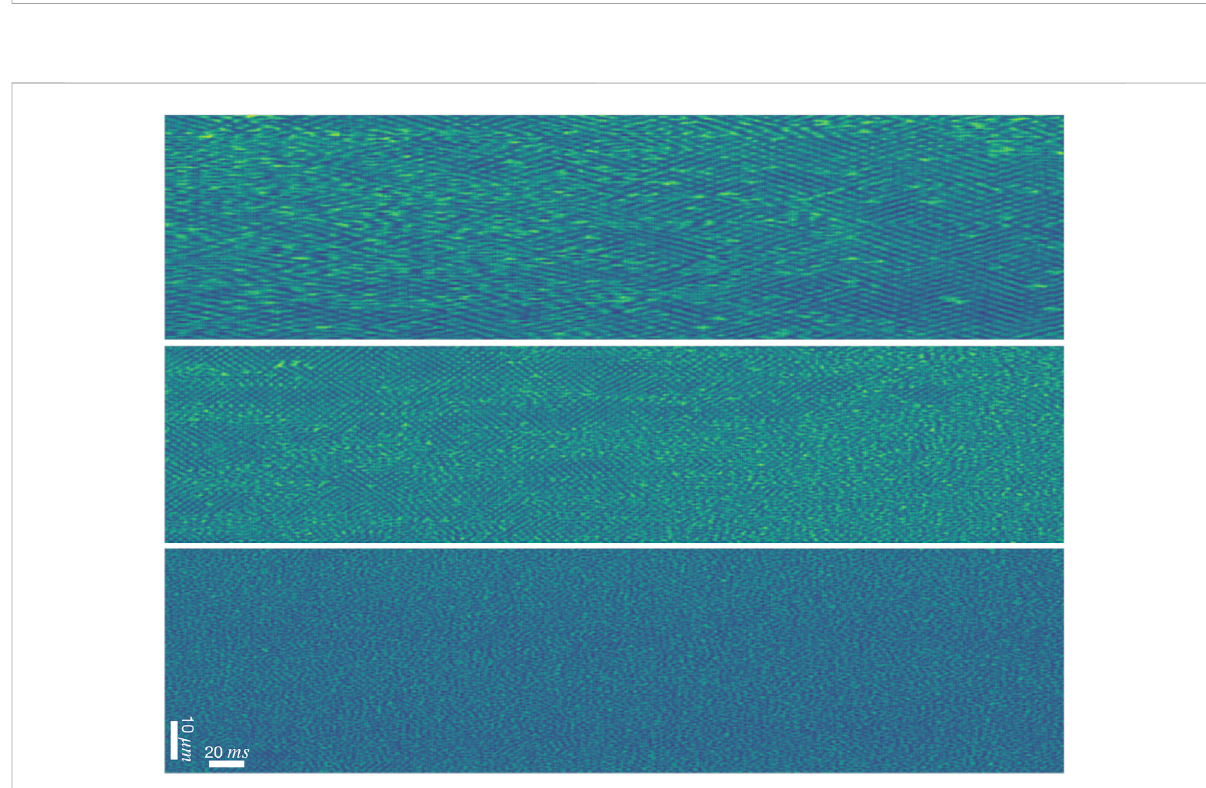
order show up as small islands in a sea of disorder, with a tendency to be longer in the time direction than in the spatial (vorticity) direction. Particle extent and separations in the time direction are proportional to the fl ow speed, so comparing dimensions (Supplementary Figure S1), or, more simply, counting the number of particle diameters in the different directions. The